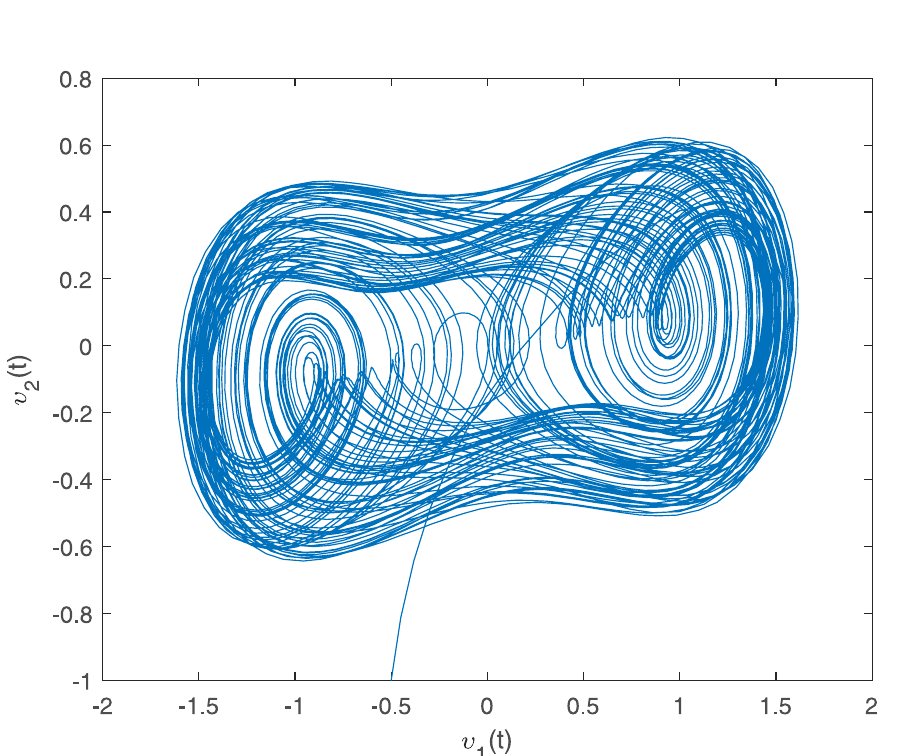
Fig 2. The diseased CACS phase portraits under ϖ ( t ) = 0 with no control input.